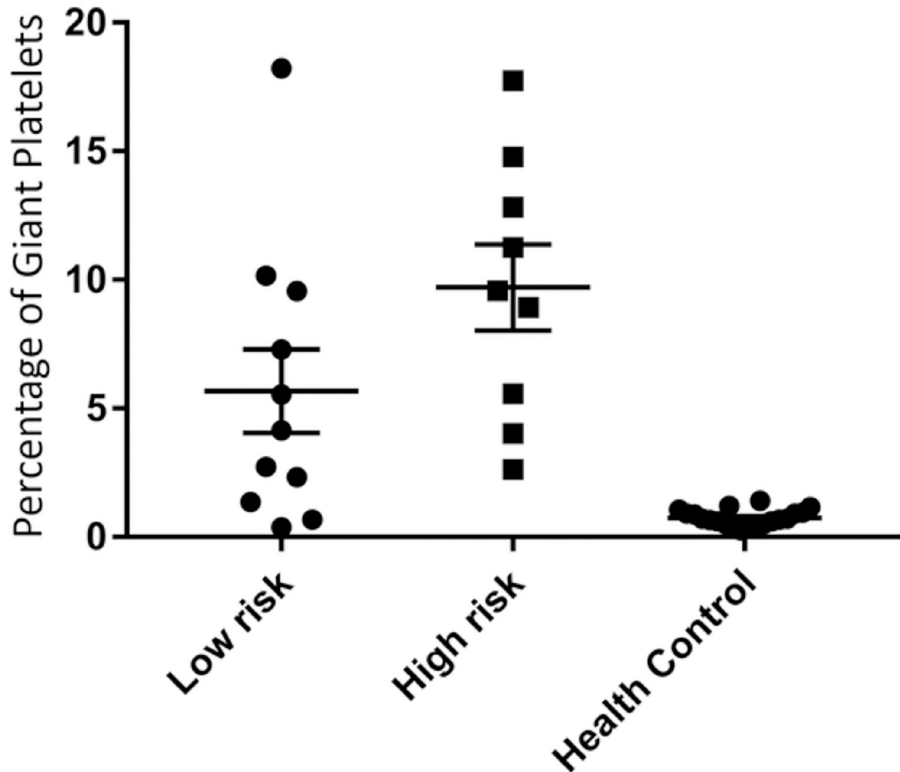
Fig 3. The percentage of giant platelets in healthy controls and patients with low-risk and high-risk MDS.